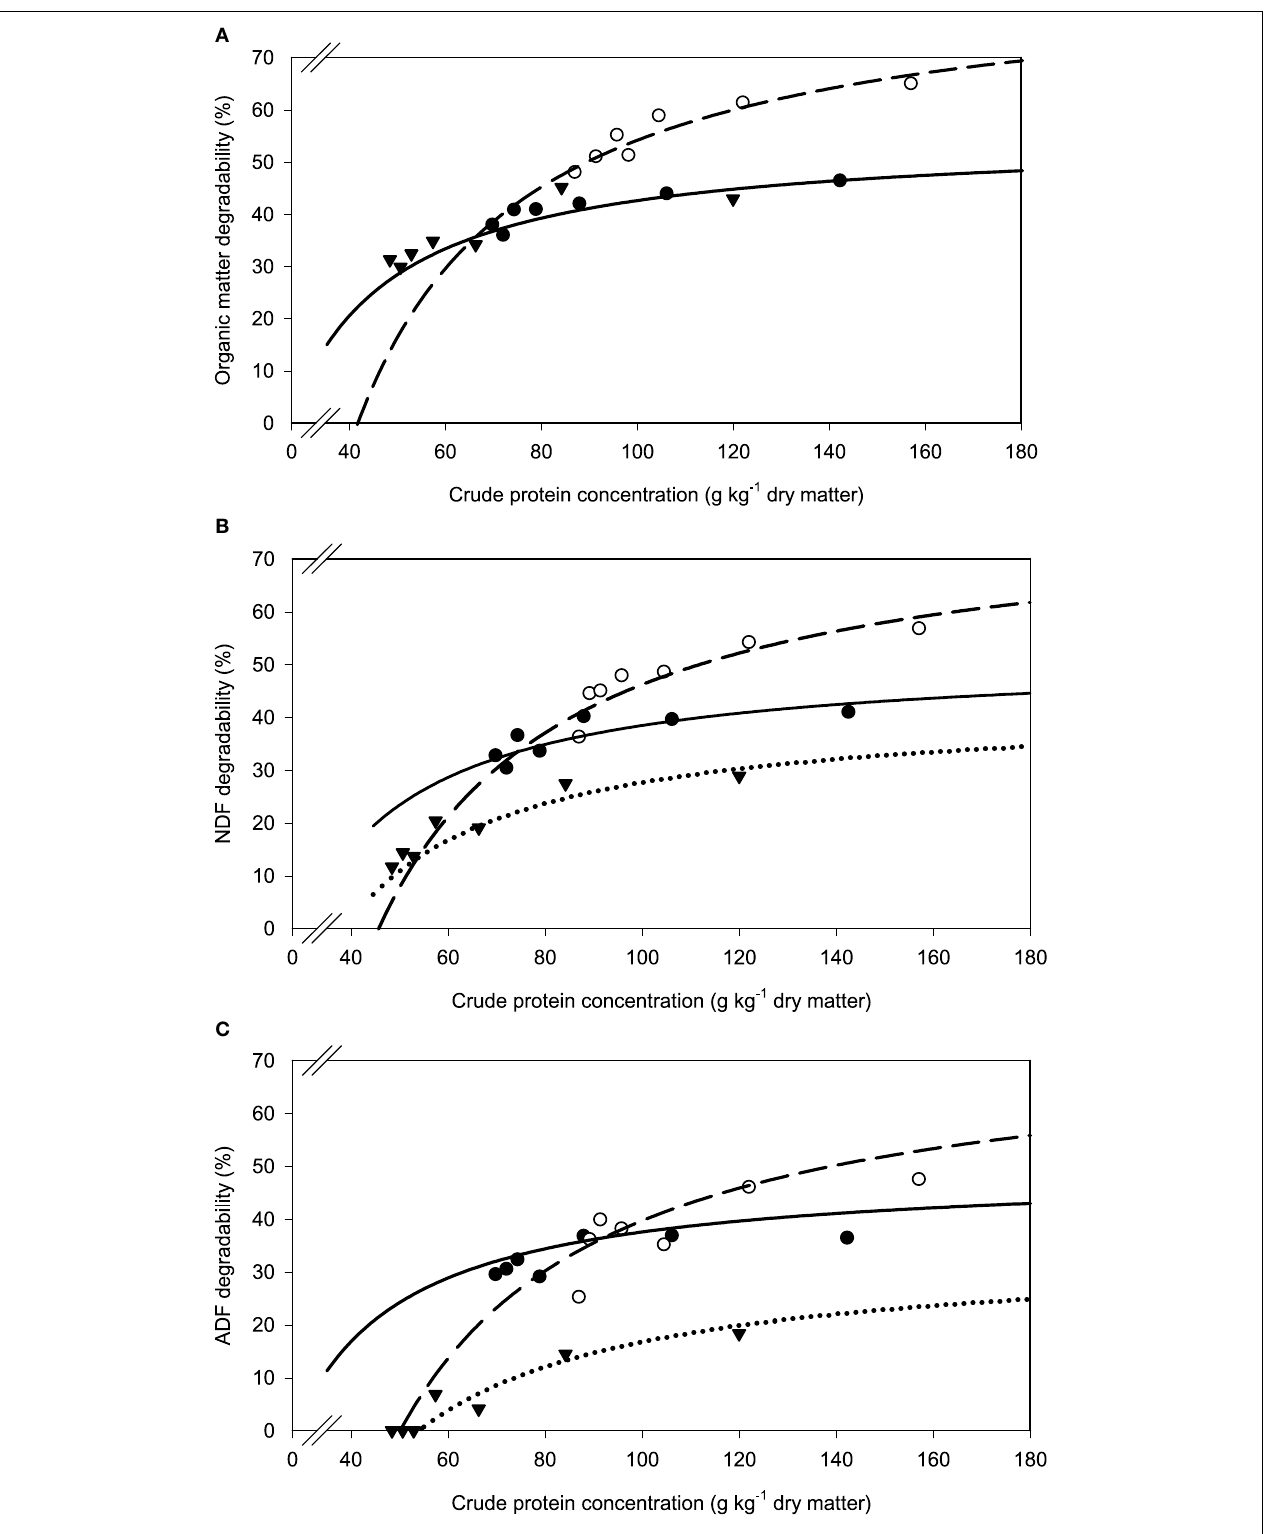
for (A) y = 55 . 3 ( ± 2.70; P < 0 . 001 ) − 1203 ( ± 225; P = 0 .0031) x − 1 , R 2 = 0 . 851 , SE = 1 . 47 , P = 0 .003, (B) y = 51 . 4 ( ± 4.6; P < 0 . 001 ) −